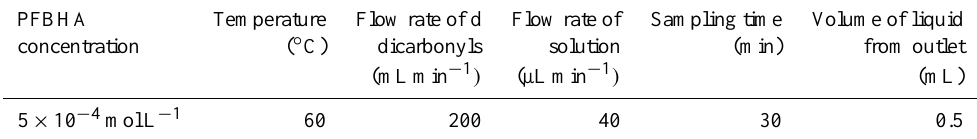
Table 1. Optimal experimental conditions for the microfluidic derivatisation reaction between PFBHA and gaseous α -dicarbonyls in the micro-reactor.